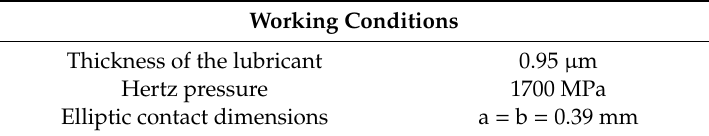
Table 2. Working conditions.